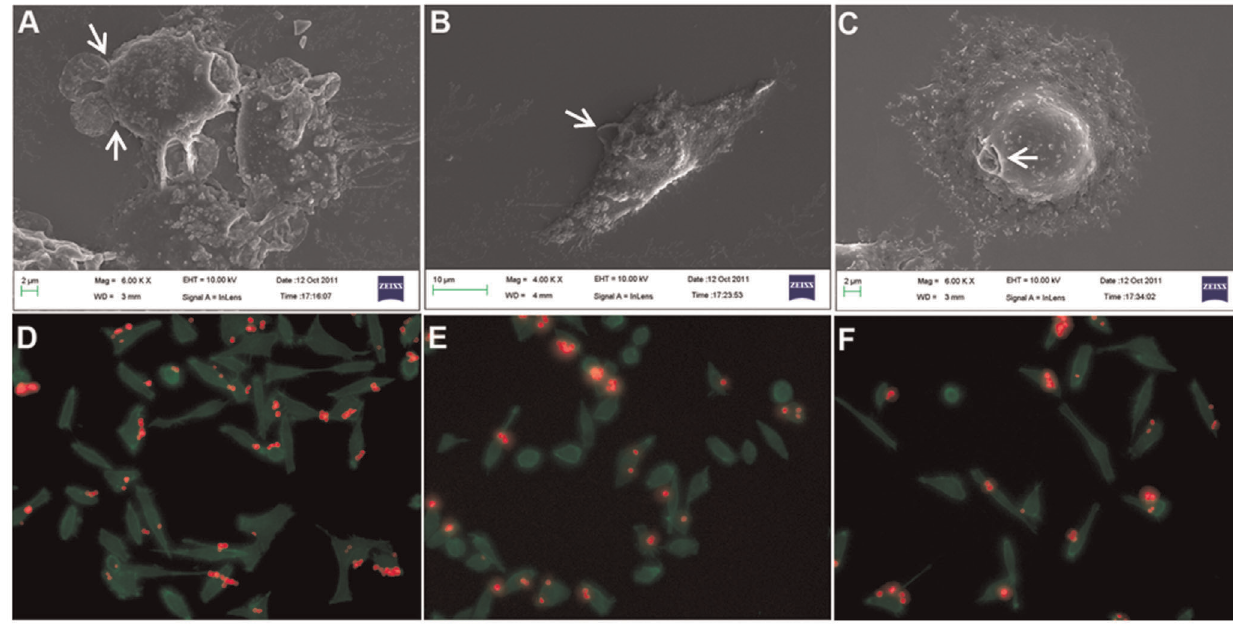
Figure 7. Kinetics of uptake of nanoparticles-loaded capsules by HeLa cells. Cell uptake kinetics of nanoparticles-loaded PSS/PAH capsules by HeLa cells followed by scanning electron microscopy (a–c) and fluorescence microscopy (d–f) as a function of time 2 h (a and d), 5 h (b and e) and 8 h (c and f). To visualize the uptake by fluorescence microscopy, LaF 3 :Tb 3 + (5%) nanoparticles were loaded in RITC-labeled PSS/PAH capsules (red emission) and actin cytoskeleton of cells was stained with FITC-Phalloidin (green). In SEM micrographs, nanoparticles-loaded capsules are indicated by white arrows.